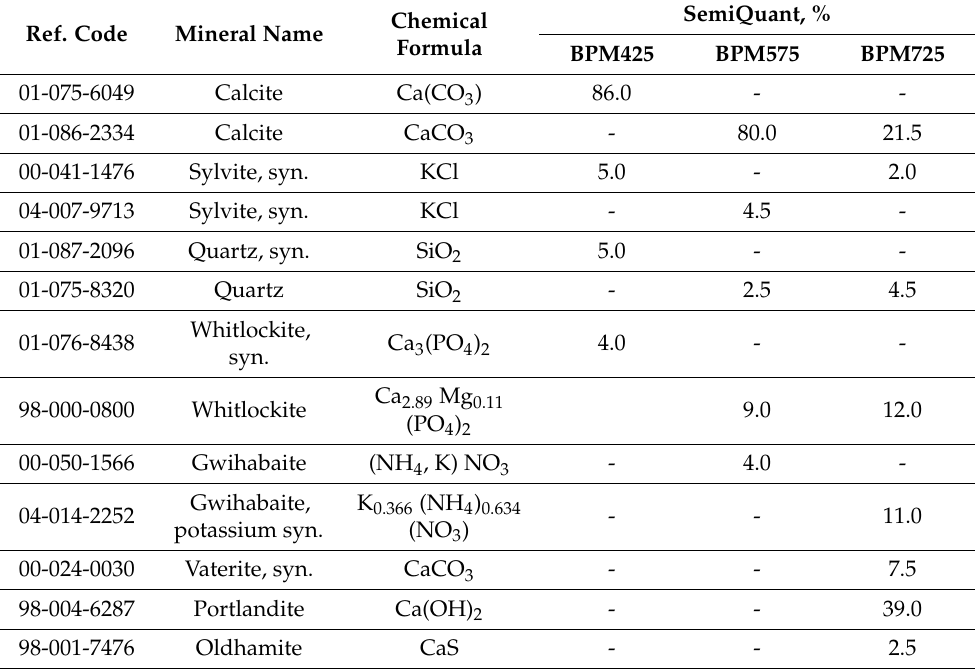
Table 5. The main mineral phases in the investigated biochars.